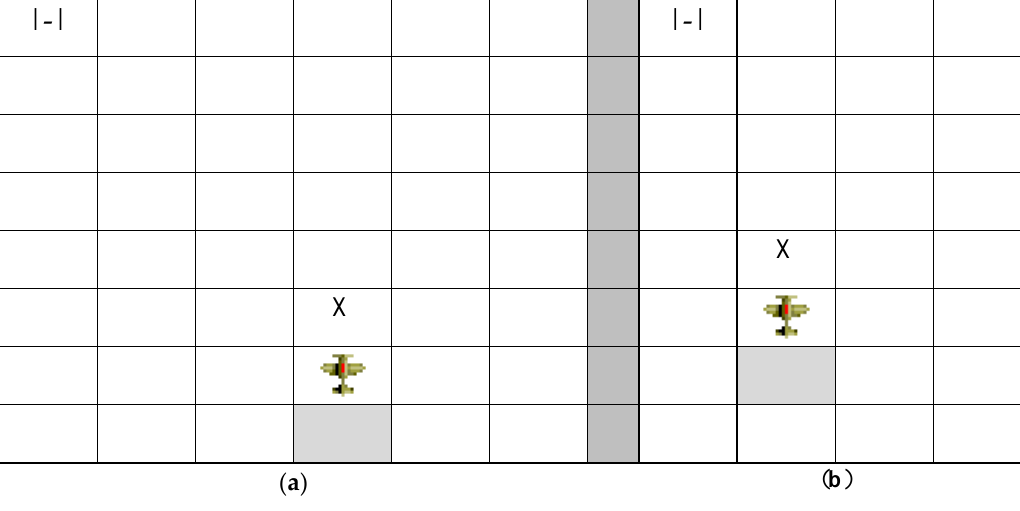
Figure 8. Example of two scenarios with obstacles and head of runway (the agent is closer to the runway in ( b ) than in ( a ) but the perception pattern is the same in both cases).